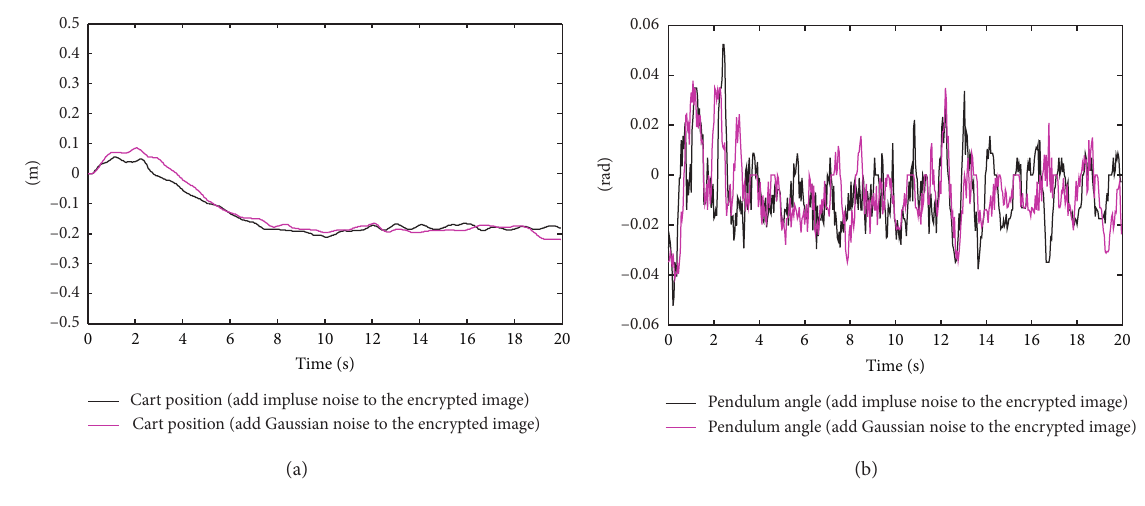
Figure 12: Real-time control effect under different image scaling ratios